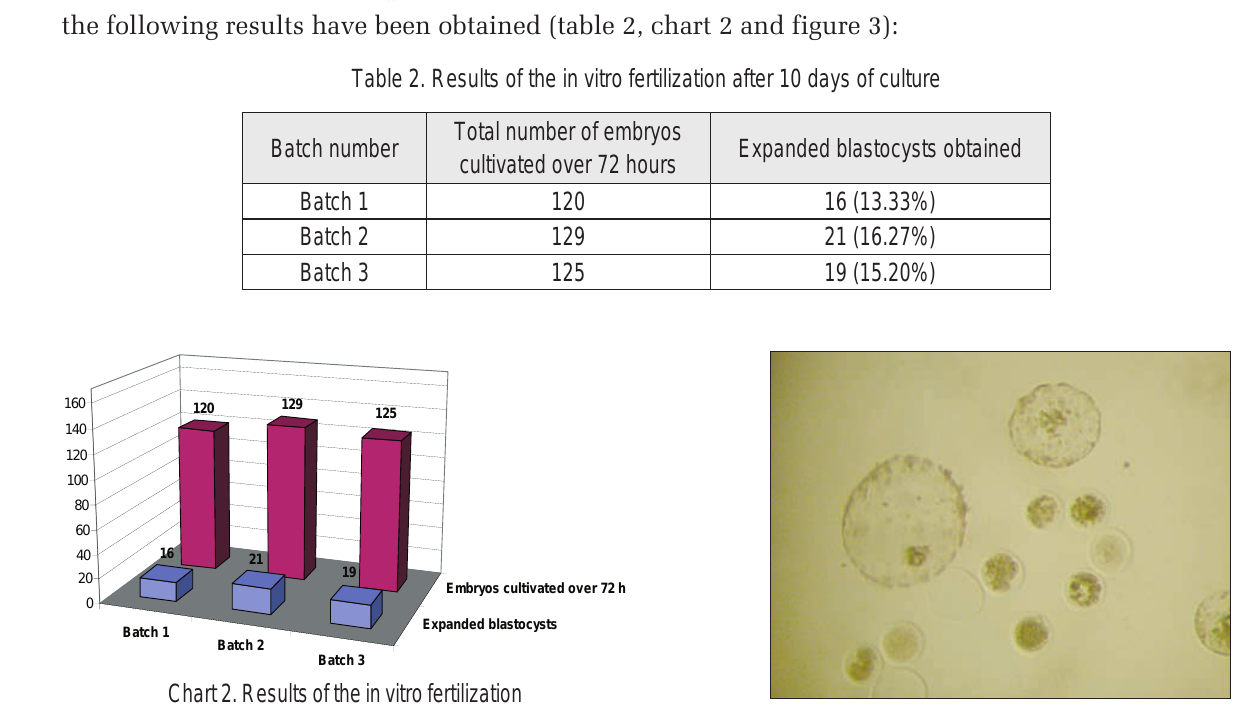
Fig. 3. Blastocysts obtained at 10 days after